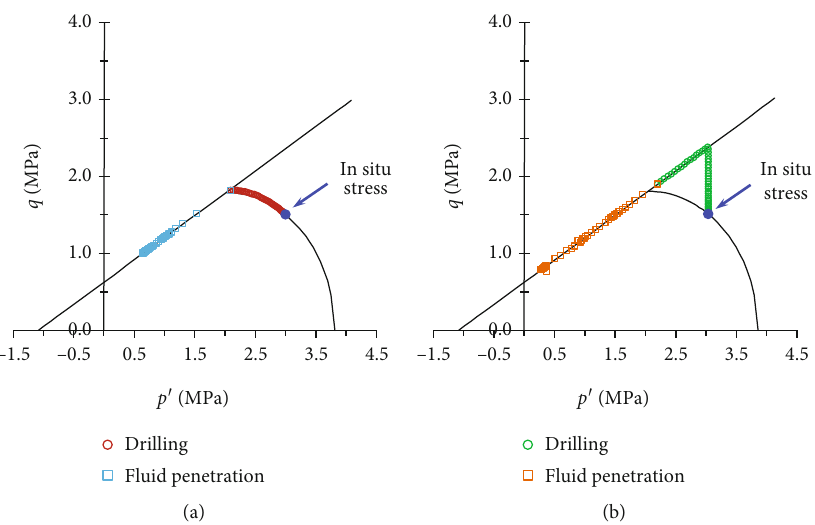
Figure 9: E ff ective stress paths experienced by a point on the wellbore surface during the drilling process and the ensuing fl uid penetration process: (a) with plastic compaction; (b) without plastic compaction (no fl ow barrier and p m of